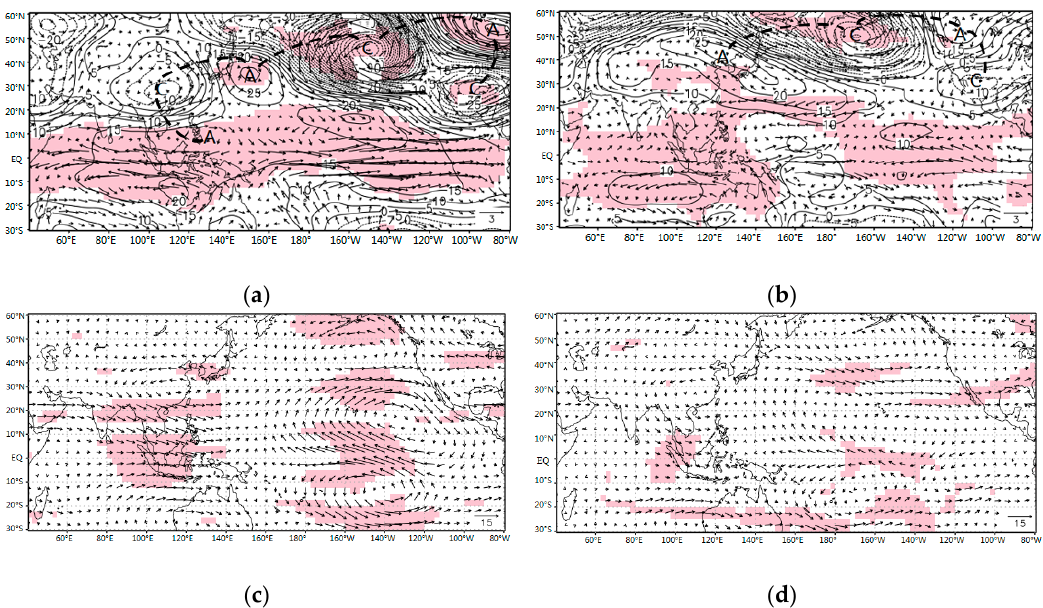
Figure 5. Composites of anomalies of ( a ) 700-hPa horizontal winds (units: m·s − 1 ) and 500-hPa geopotential height (contours; units: gpm) and ( c ) 150-hPa horizontal winds (units: m·s − 1 ) during DJF 1979–2016 for the spring El Niño events. Panels ( b , d ) show the same but for the summer El Niño events. The wind scale is shown at the bottom of the respective panels. The contour interval is 10 gpm. Shaded areas indicate statistical significance at the 95% confidence level, based on the Student’s t